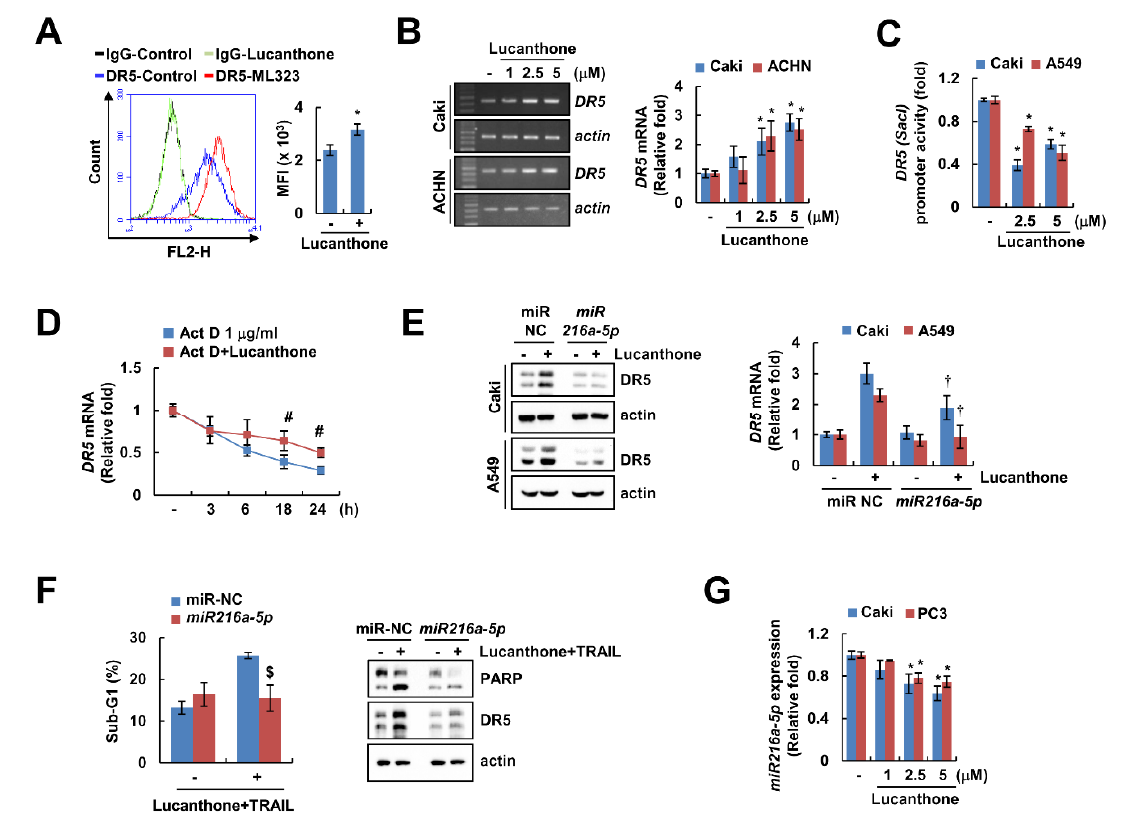
Figure 5. Lucanthone increases DR5 mRNA expression through decrease of miR-216a-5p . ( A ) Caki cells were treated with 5 μM lucanthone for 24 h and analyzed DR5 expression on the cell surface using flow cytometry. ( B ) Caki and ACNH cells were treated with 1–5 μM lucanthone for 24 h. The mRNA levels of DR5 and actin were examined by RT-PCR and qPCR; ( C ) Caki and A549 cells were transfected with DR5 (-Sac1) promoter and then treated with 2.5–5 μM lucanthone for 24 h. The cells were lysed, and then promoter activity was measured. ( D ) Caki cells were pretreated with 1 μg/mL actinomycin D (Act D) for 30 min and then treated with 5 μM lucanthone for the indicated time periods. The mRNA levels of DR5 was quantified by RT-PCR and qPCR; ( E,F ) Caki and A549 cells were transfected with miR-negative control (NC) and miR-216a-5p and then treated with ( E ) 5 μM lucanthone or ( F ) combinations of 5 μM lucanthone with 50 ng/ml TRAIL for 24 h. ( G ) Caki and PC3 cells were treated with 1–5 μM lucanthone for 24 h. The expression of miR-216a-5p was determined by qPCR. ( E , F ) The protein expression and ( F ) sub-G1 population were measured by Western blotting and flow cytometry, respectively. The values in graph represent the mean ± SD of three independent samples. * p < 0.05 compared to control. # p < 0.05 compared to the Act D. † p < 0.05 compared to lucanthone in miR-NC. $ p < 0.05 compared to combinations of lucanthone and TRAIL in miR-NC.